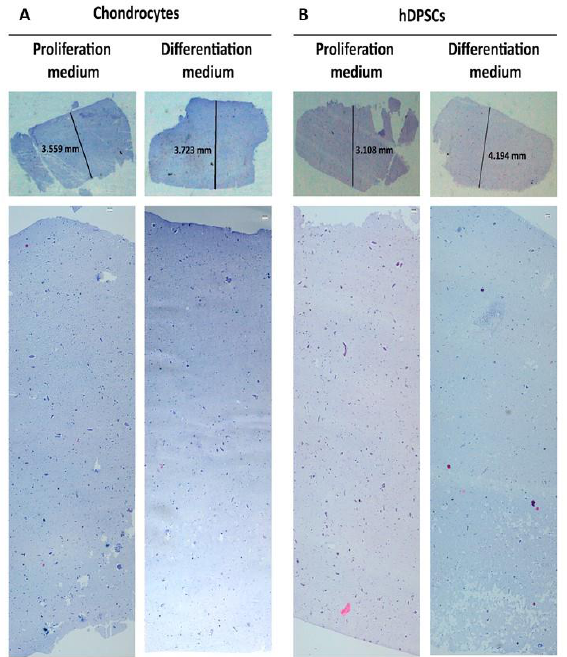
Figure 5. Distribution of cells along the manufactured hydrogels. Human primary chondrocytes ( A ) or hDPSCs ( B ) were cultured in hydrogels containing 3% alginate and 1% agarose, with proliferation or differentiation medium for up to 6 weeks at a density of 2 × 10 6 cells/ml. Scaffolds were fixed, paraffin embedded and stained with hematoxylin eosin. Panoramic images are shown where the cell distribution is observed along the scaffolds. Representative results from three dif- ferent experiments are shown. Numbers indicate the height. Scale bars = 100 µm. 3.4. Chondral Differentiation of Chondrocytes Cultured in Alginate-Agarose Scaffolds The induction of the chondrogenic phenotype in the alginate-agarose scaffolds was analyzed. Cells were cultured in 3% alginate-1% agarose scaffolds for 2, 4 and 6 weeks. Cytoskeletal morphology, distribution and organization were evaluated by F-actin fluo- rescence staining using rhodamine-phalloidin, as described in Methods. Fluorescence im- ages were obtained by confocal microscopy. The results are summarized in Figure 6A–F. Spheroidal aggregates of cells were observed in all groups analyzed. These aggregates were more abundant and larger in the 4- and 6-week cultures compared to the 2-week groups, in which small groups of 2–4 cells were found. These differences increased when differentiation medium was used, which resulted in larger and more numerous cell ag- gregates than those observed in cultures with proliferation medium (Figures 6D,F). As observed in the 2D-culture, the F-actin filaments showed a peripheral distribution in the